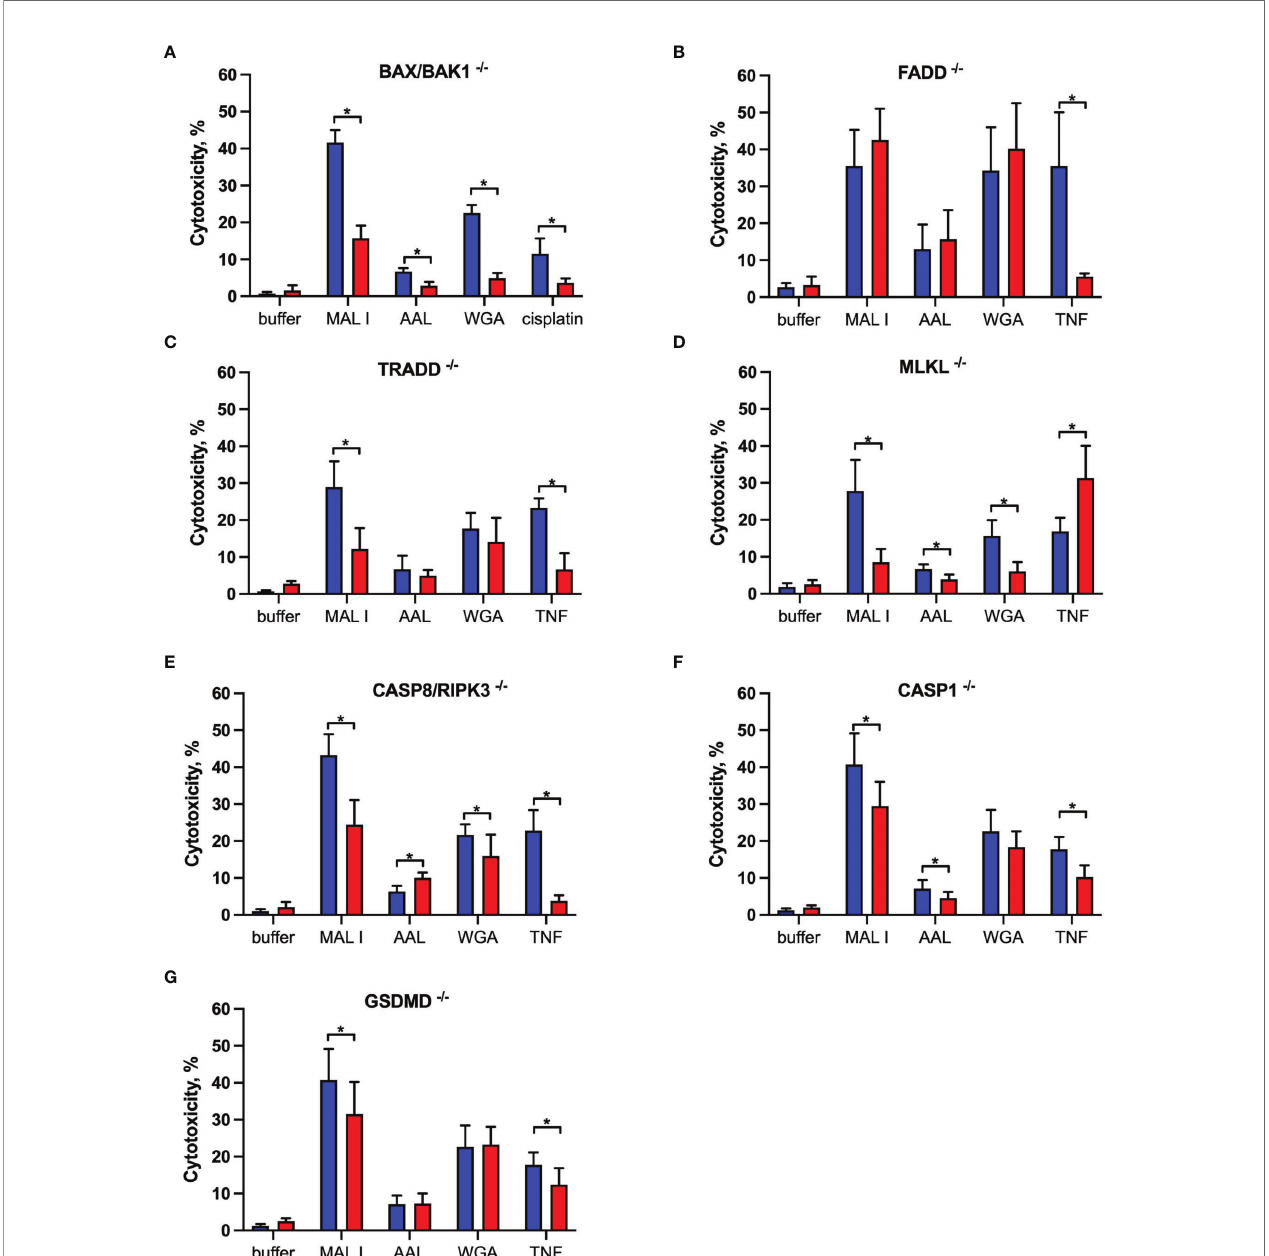
FIGURE 3 | Effects of single gene knockouts on lectin-induced cell death in MC-38 cells. Intrinsic apoptosis was assessed by inactivation of BAK/BAX (A) , whereas extrinsic apoptosis and necroptosis pathways were assessed by inactivation of FADD (B) , TRADD (C) , MLKL (D) , and combined caspase 8/RIPK3 (E) genes. Pyroptosis was assessed by caspase 1 (F) and GSDMD (G) gene inactivation. To exclude clonal effects, all experiments were performed in at least two clones for each gene knockout. Data represent 6 replicates from at least 2 independent experiments. WT (blue bars), gene knockouts (red bars). *p < 0.05; unpaired two-tailed